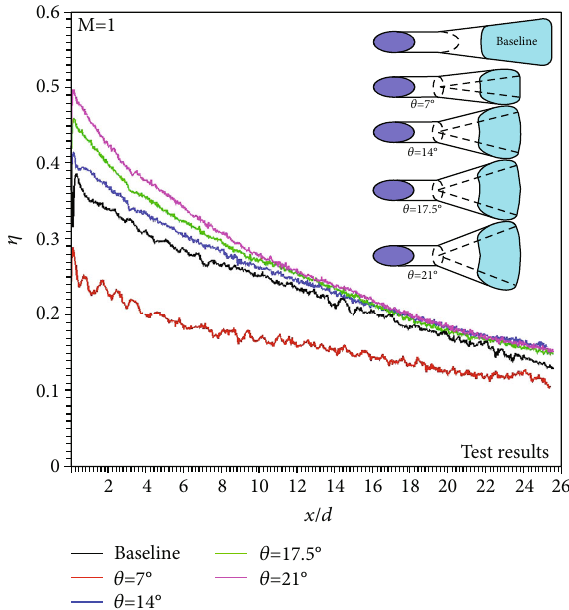
Figure 21: Streamwise variation of measured fi lm e ff ectiveness (spanwise-averaged at each point) for the blowing ratio of 1.